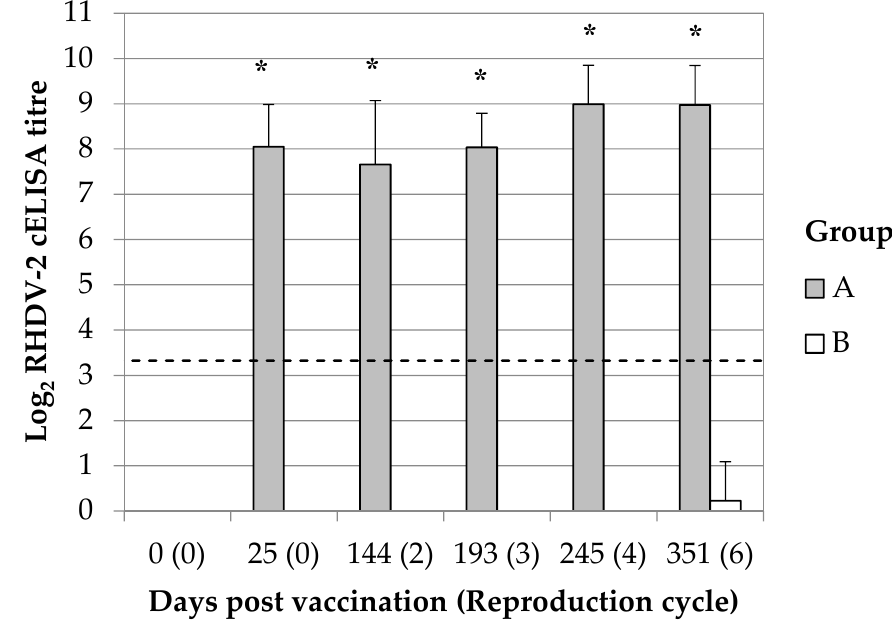
Figure 1. RHDV-2 antibody response in breeding does. Results are represented as average and standard deviation. Breeding does were vaccinated either with ERAVAC ® (Group A) or inoculated with PBS (Group B). The slashed line indicates the cut-off of the assay (3.32 Log 2 cELISA titre). Asterisks (*) indicate statistically significant differences between groups (Mann-Whitney U test, p < 0.05).